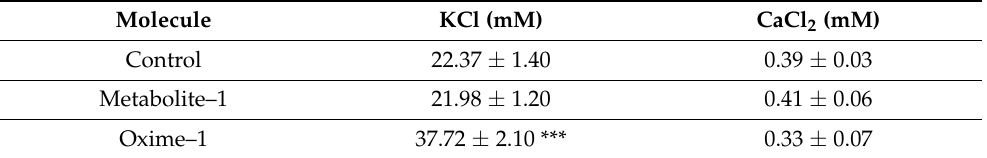
Table 4. Effect of metabolite–1 or oxime–1 on contractile response to KCl (10 to 60 mM) in intact Table 3. Relaxation effect of metabolite–1 or oxime–1 in pre-contracted aortic rings with PE: in pres- ence, absence of endothelium, and pre-incubated with 10 − 4 M L-NAME. aortic rings incubated under different Ca 2+ concentrations in the external